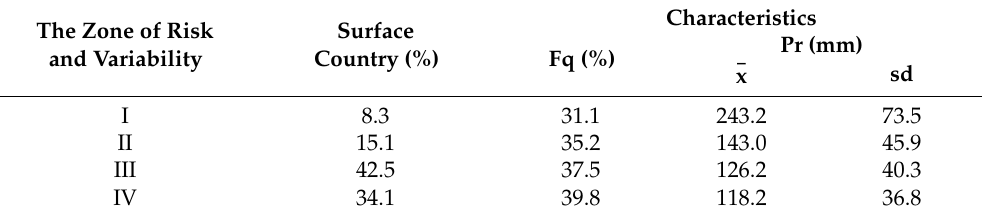
Table 3. Characteristics of the zones of risk and variability of spring (from March to May) precipitation deficits in Poland. Years 1951–2018.